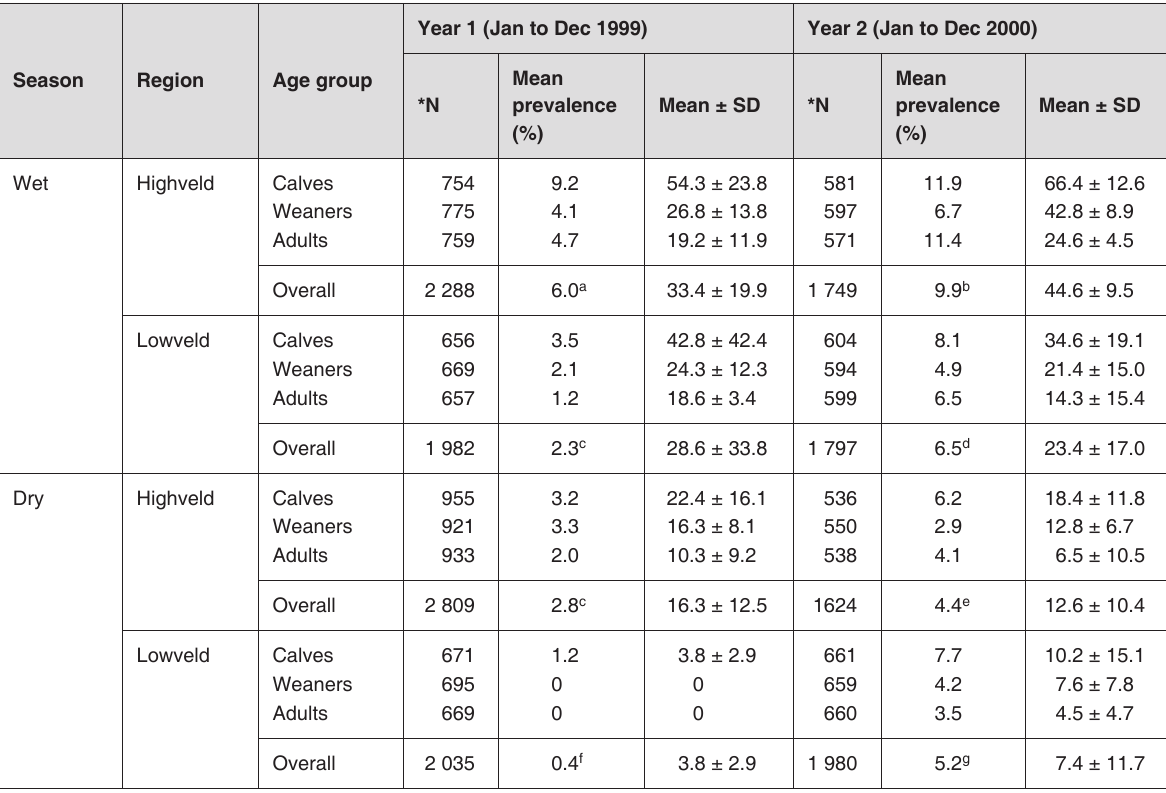
TABLE 4 Recovery of Bulinus globosus from seven districts in the highveld and lowveld communal grazing areas of Zimbabwe for the period November 1998 to October 2000